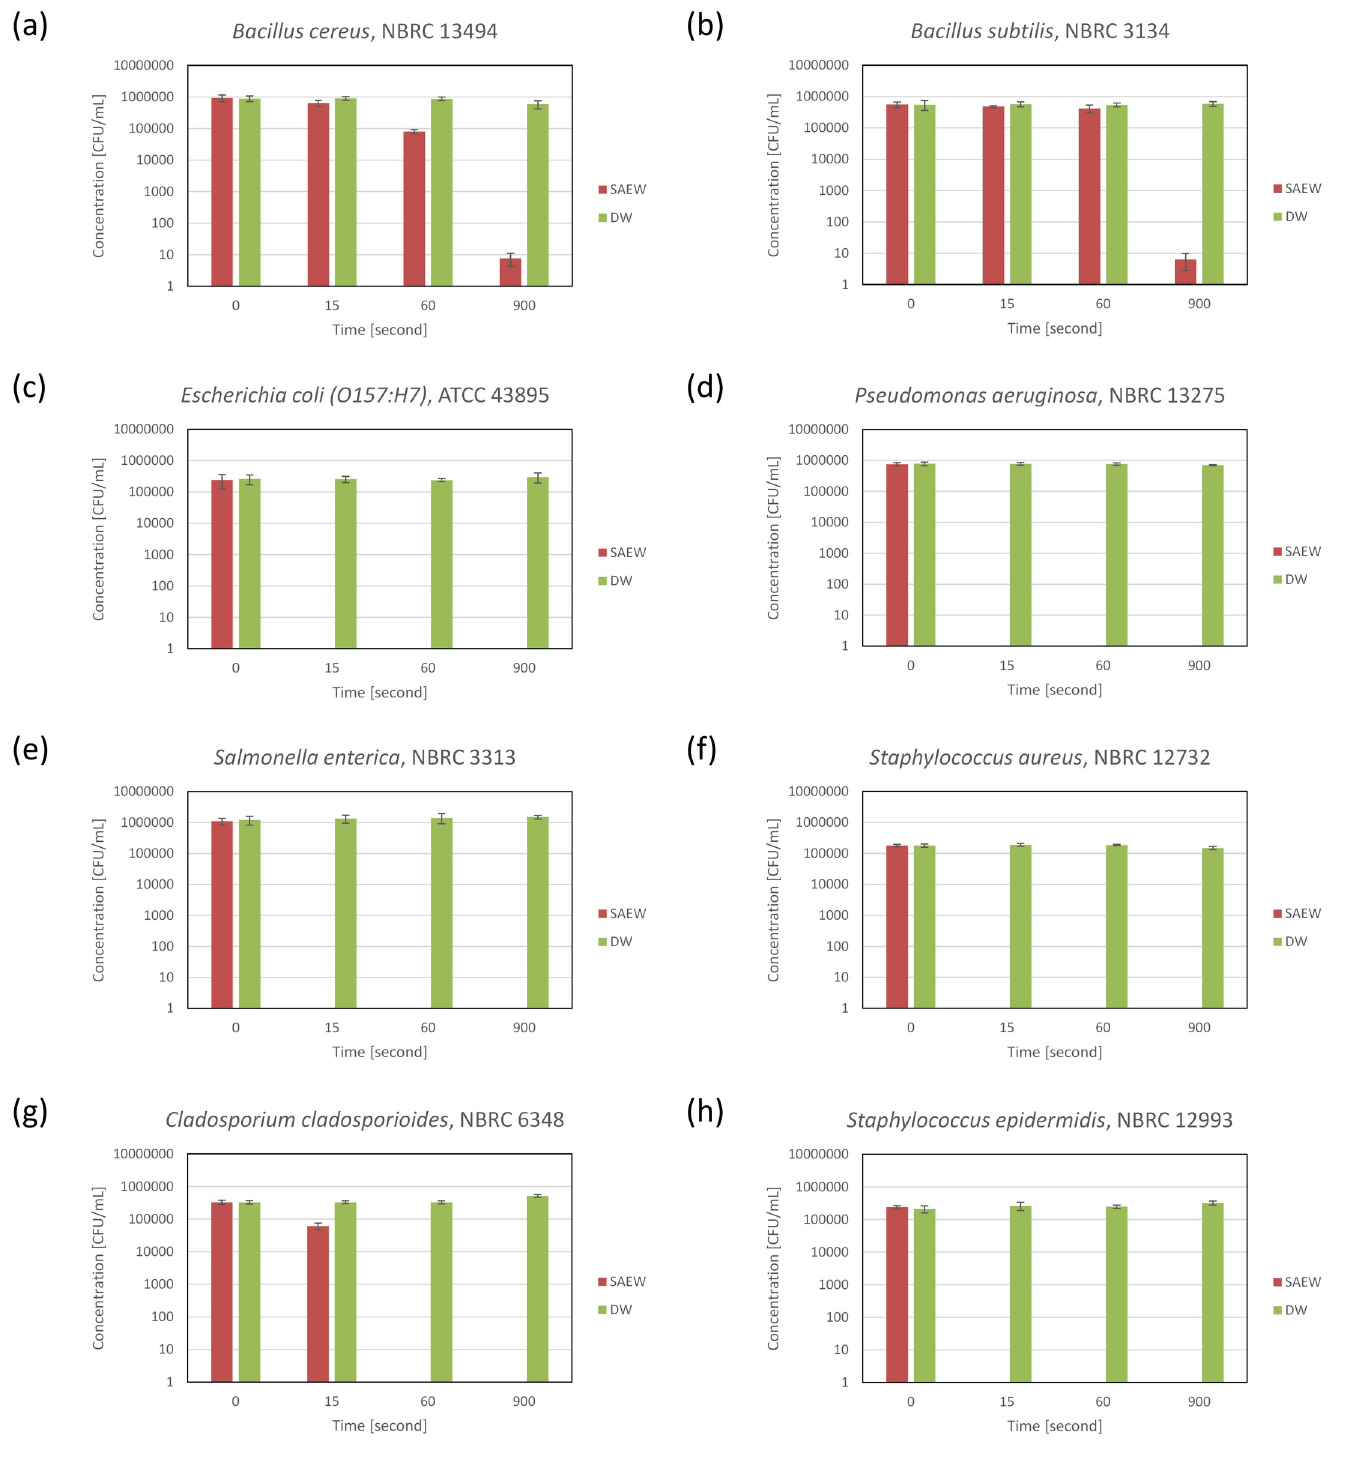
Fig 1. Effects of SAEW on pure cultures (a) Bacillus cereus , (b) Bacillus subtilis , (c) Escherichia coli (O157:H7), (d) Pseudomonas aeruginosa , (e) Salmonella enterica subsp . enterica , (f) Staphylococcus aureus subsp . aureus , (g) Cladosporium cladosporioides , and (h) Staphylococcus epidermidis .